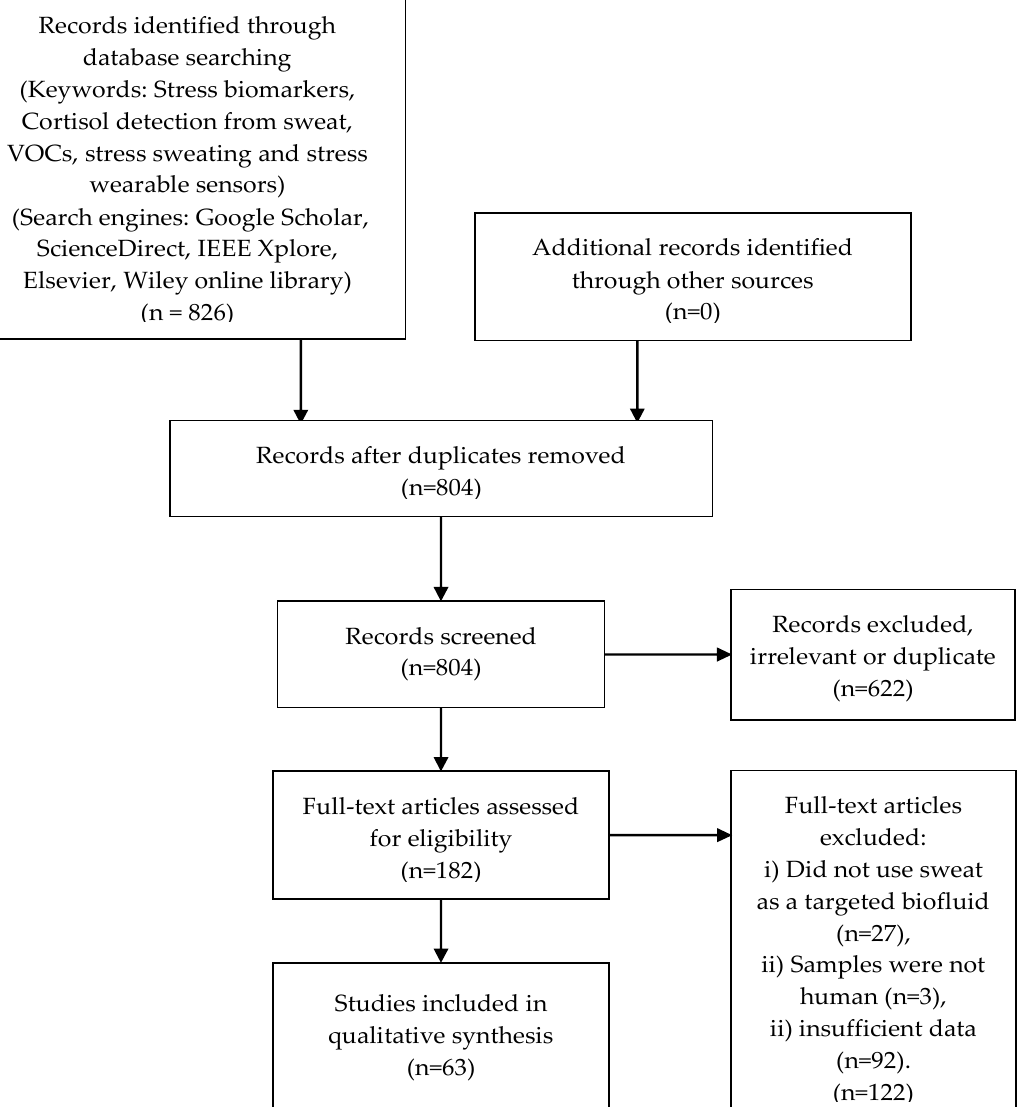
Figure 1. PRISMA process adopted and the results obtained in this review.